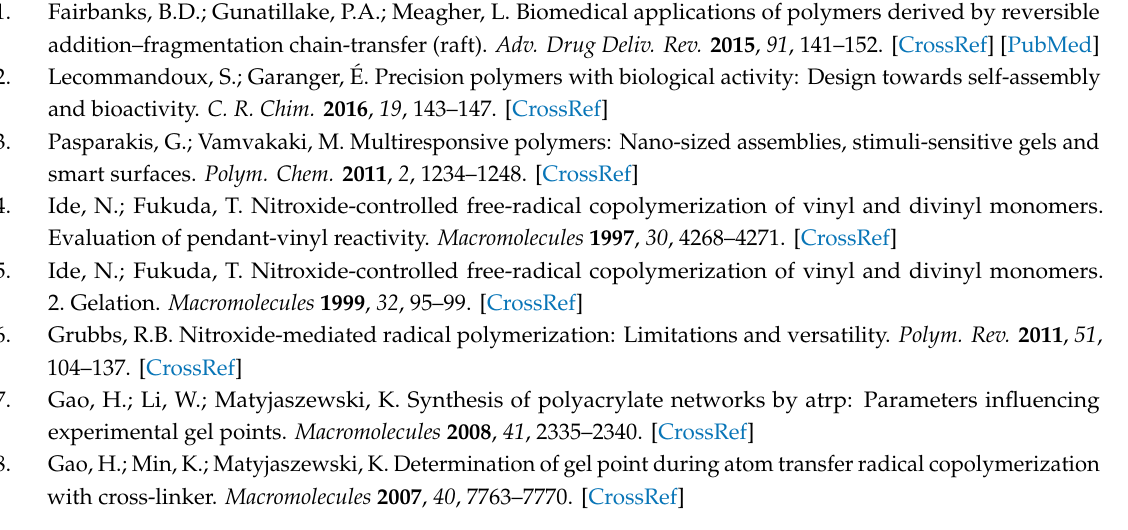
Figure S1: 1 H NMR (400 MHz, CDCl 3 ) of PNIPAAm synthesised using (a) FRP and (b) RAFT polymerization, Figure S2: GPC trace of PNIPAAm synthesised using FRP (green) and RAFT polymerization (blue), Figure S3: Release of fluorscein from G2F (a) and G2R (b) in di ff erent